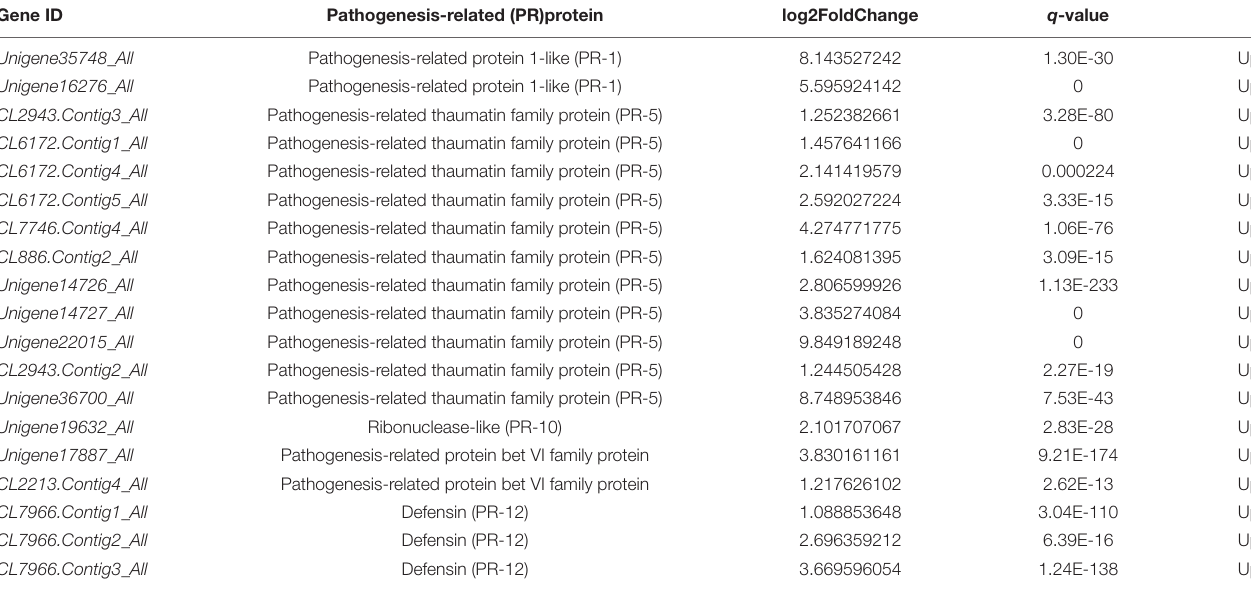
TABLE 3 | Genes regulating PR proteins in the NMP vs